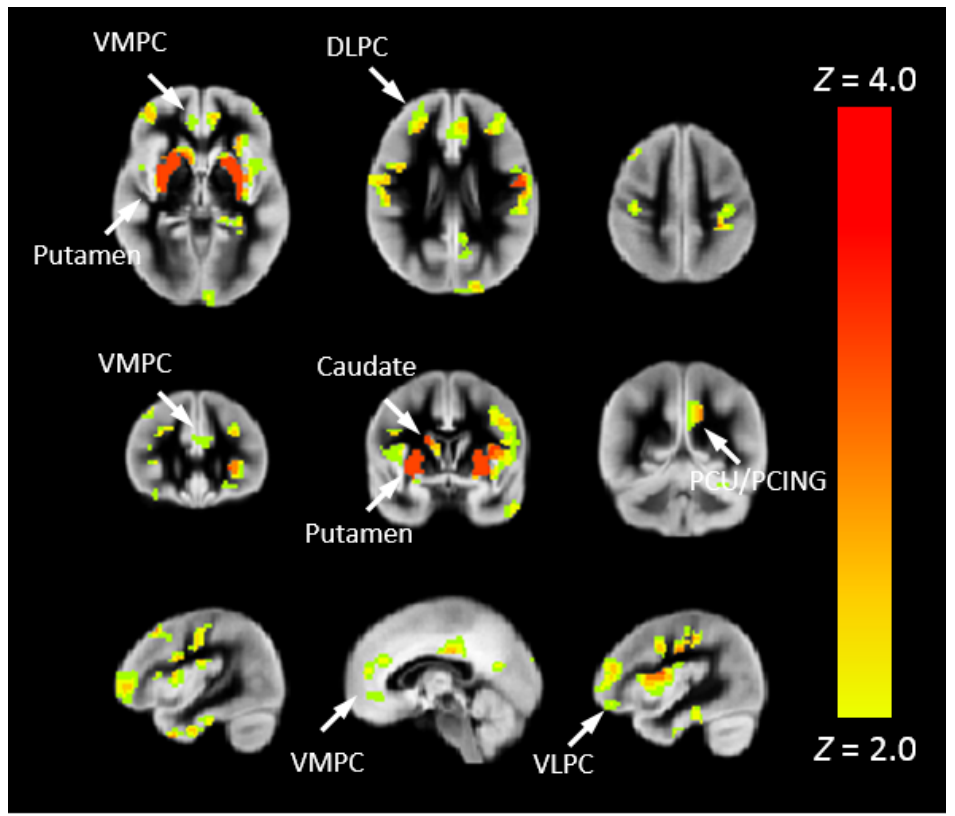
Figure 6. Nasal nitric oxide (nNO) positively correlates with Pnvf in children and younger adults with CHD and normal referents. Regions with a positive correlation of Pnvf with nNO (controlling for age and gender) are mainly concentrated in DMN and CEN regions as well as the putamen. All regions significant at FDR-corrected q < 0.05. Abbreviations: Ventrolateral medial prefrontal cortex (VMPC), Insula (INS), Dorsolateral prefrontal cortex (DLPC), Posterior Cingulate (PCING), Precu- neus (PCU), Dorsal Anterior Cingulate Cortex (DACC), Posterior Parietal (PP).